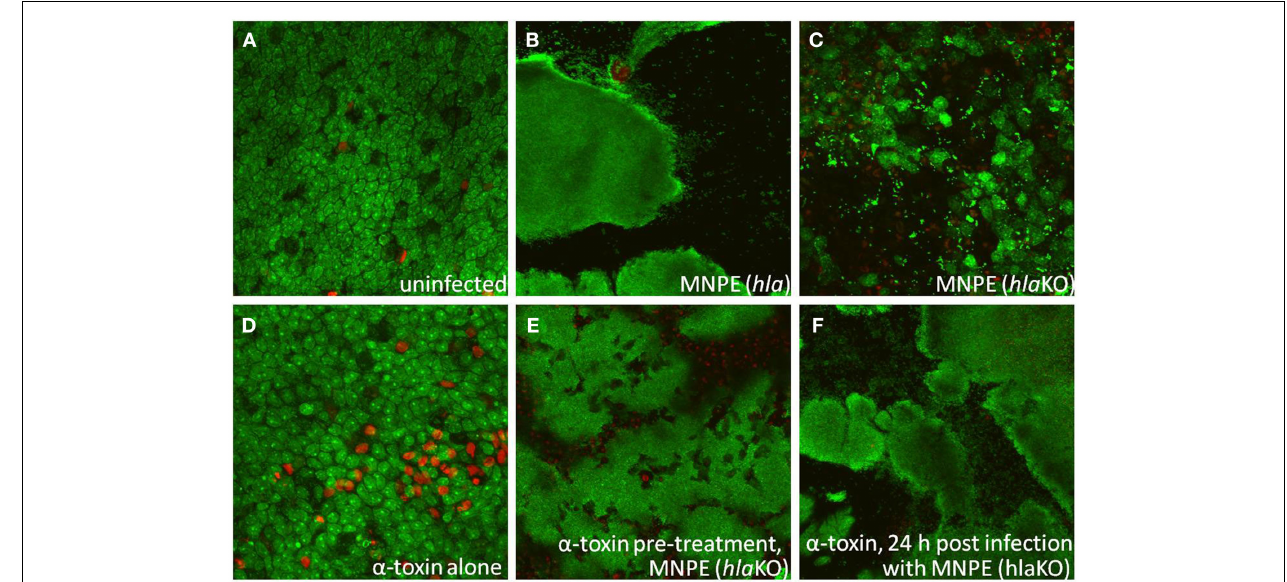
hla KO. Live individual cocci and small aggregates (small, bright punctuate, and irregular shaped green staining) are evident. Many cells of the mucosa remain alive (green ovals/circles). (D) Treatment of mucosa with 5 μ g purified α -toxin alone for 72h results in a slight increase in cytotoxicity (red staining). (E) Treatment of mucosa with 5 μ g purified α -toxin for 6h prior to infection with MNPE hla KO restores biofilm formation. (F) Treatment with 5 μ g α -toxin 24h